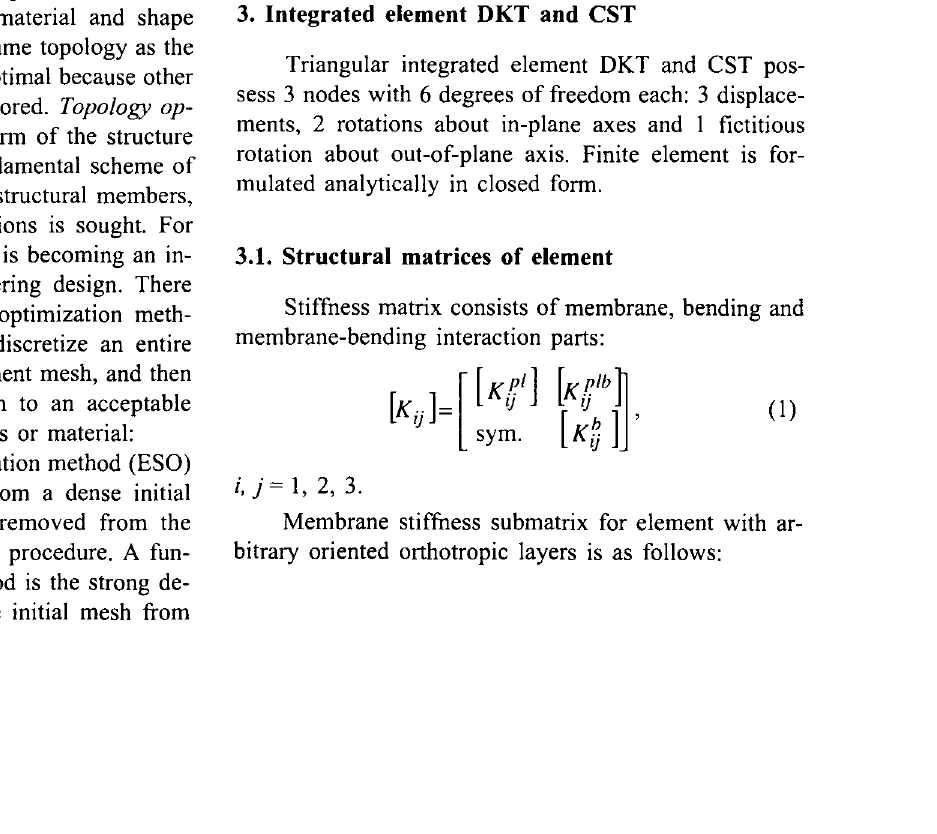
Fig 1. Categories of structural optimization [4] Material optimization. The material and cross-sec tion layout characteristics are the design parameters for this problem. The orthotropy orientation angles in par ticular layers, thicknesses of layers, layers' stacking se quence, etc [4] may be chosen as the design parameters for laminated structures. Shape optimization. With shape optimization the ing optimization process. The object of optimization is to find the best shape that will have the best optimum criterion outcome. Only the parameters on which the shape of structure depends ( eg coordinates of contour in simplest case) are chosen as the design parameters. There are several techniques for solving the problem: mathema tical programming, evolutionary structural optimization, and simulated biological growth